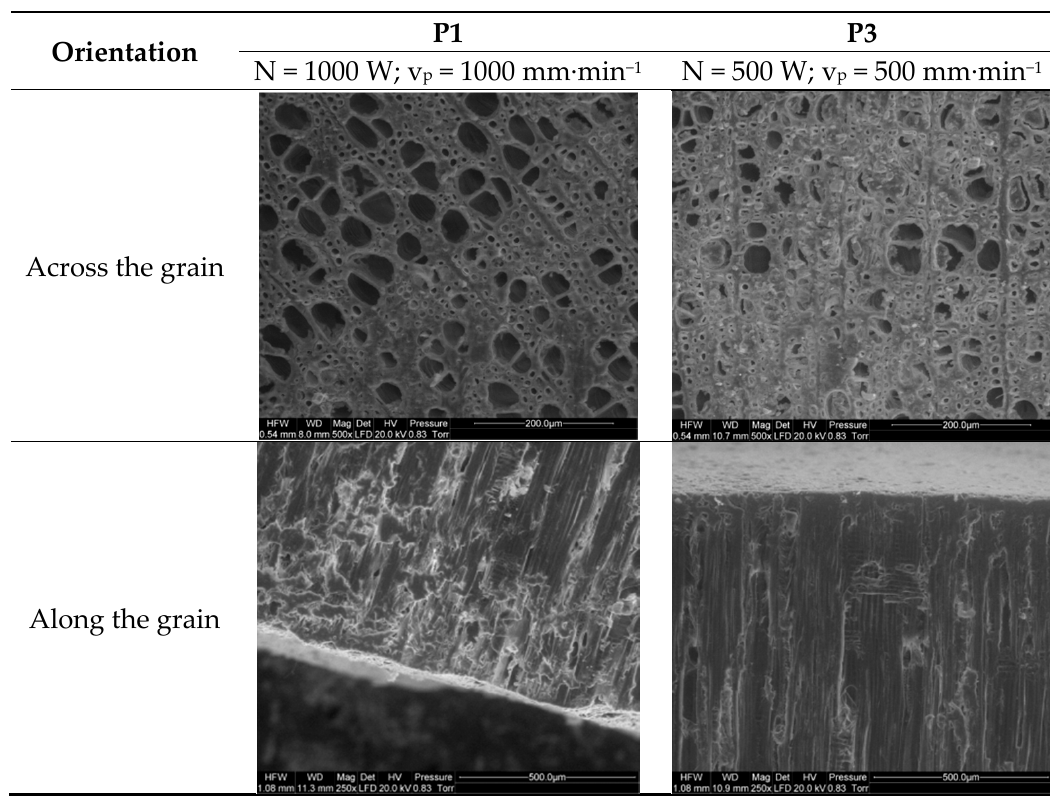
Figure 9. Cellular structure of poplar wood after laser cutting in trials P1 and P3.